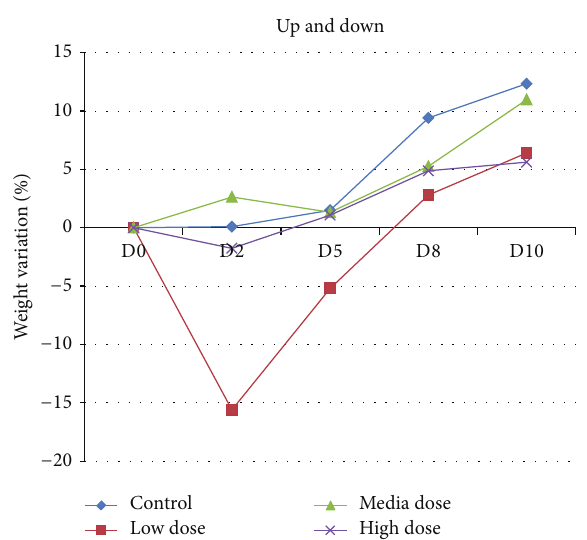
Figure 8: % of weight variation in the Up and Down assay. The 𝑋 - axes show the days after treatment (D: day) while the 𝑌 -axes show the percentage of weight variation after treatment compared to the initial